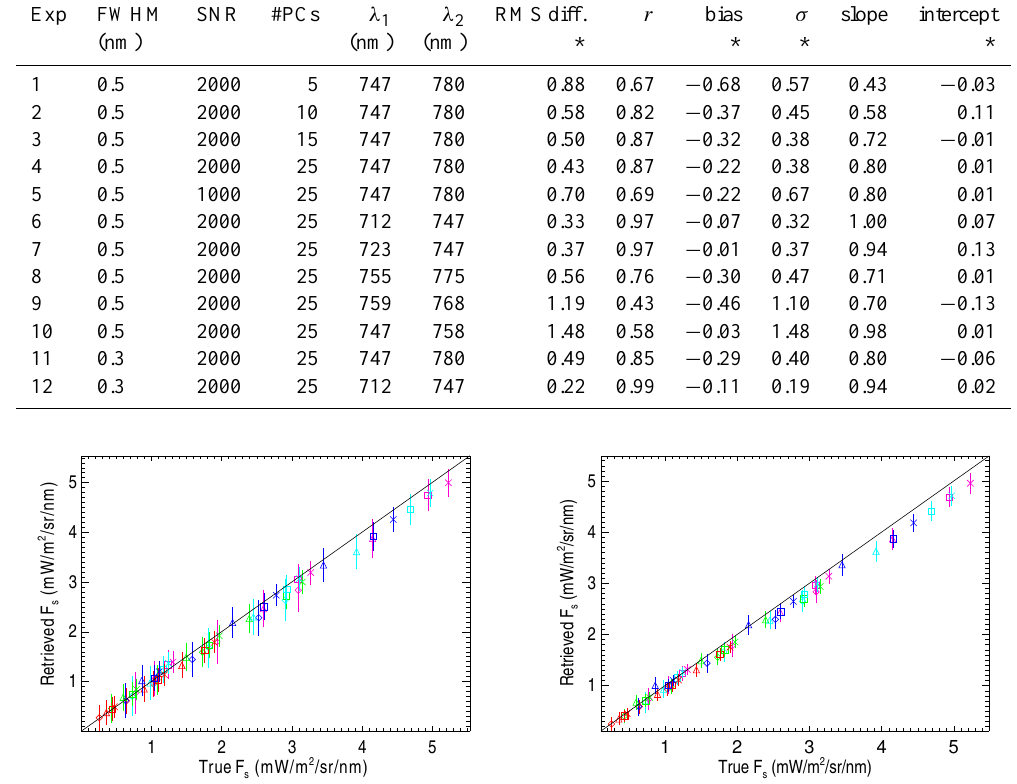
Fig. 12. Fluorescence retrievals from simulated data ( y axis) using wavelengths between 712 and 747nm for instruments with FWHM = 0.5nm (left) and FWHM = 0.3nm (right), both with a signal-to-noise ratio of 2000. Fluorescence is averaged over the wavelengths used in the retrieval and compared with the “truth” ( x axis) averaged in the same way. Standard deviations are shown with vertical bars. Different symbols are shown for the various values of chlorophyll content, and different colors are for the different values of leaf area index.